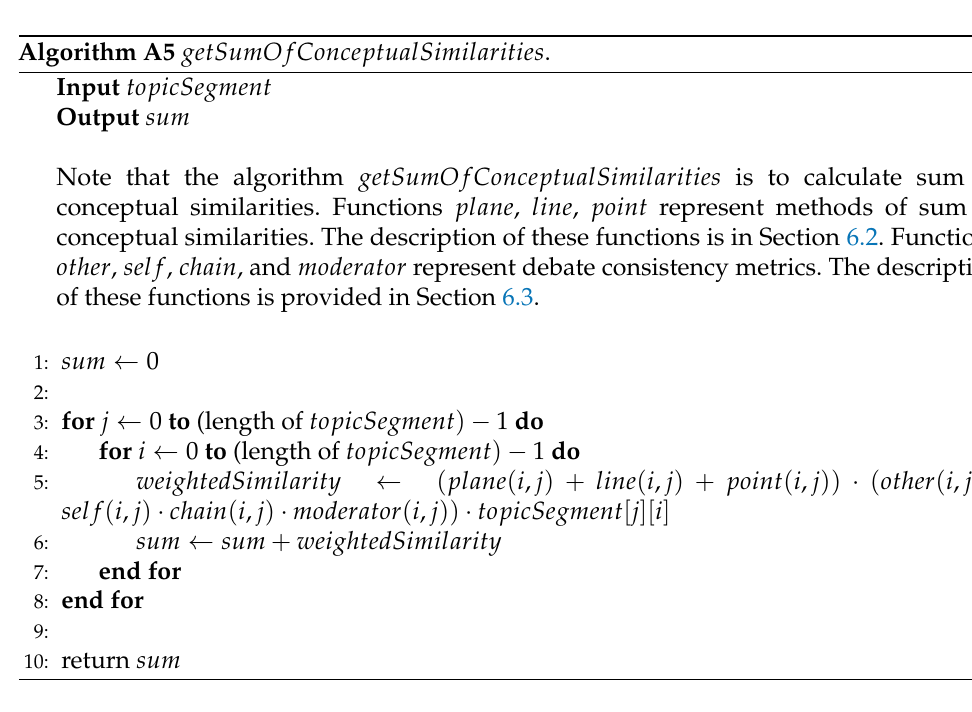
Algorithm A5 getSumO f ConceptualSimilarities